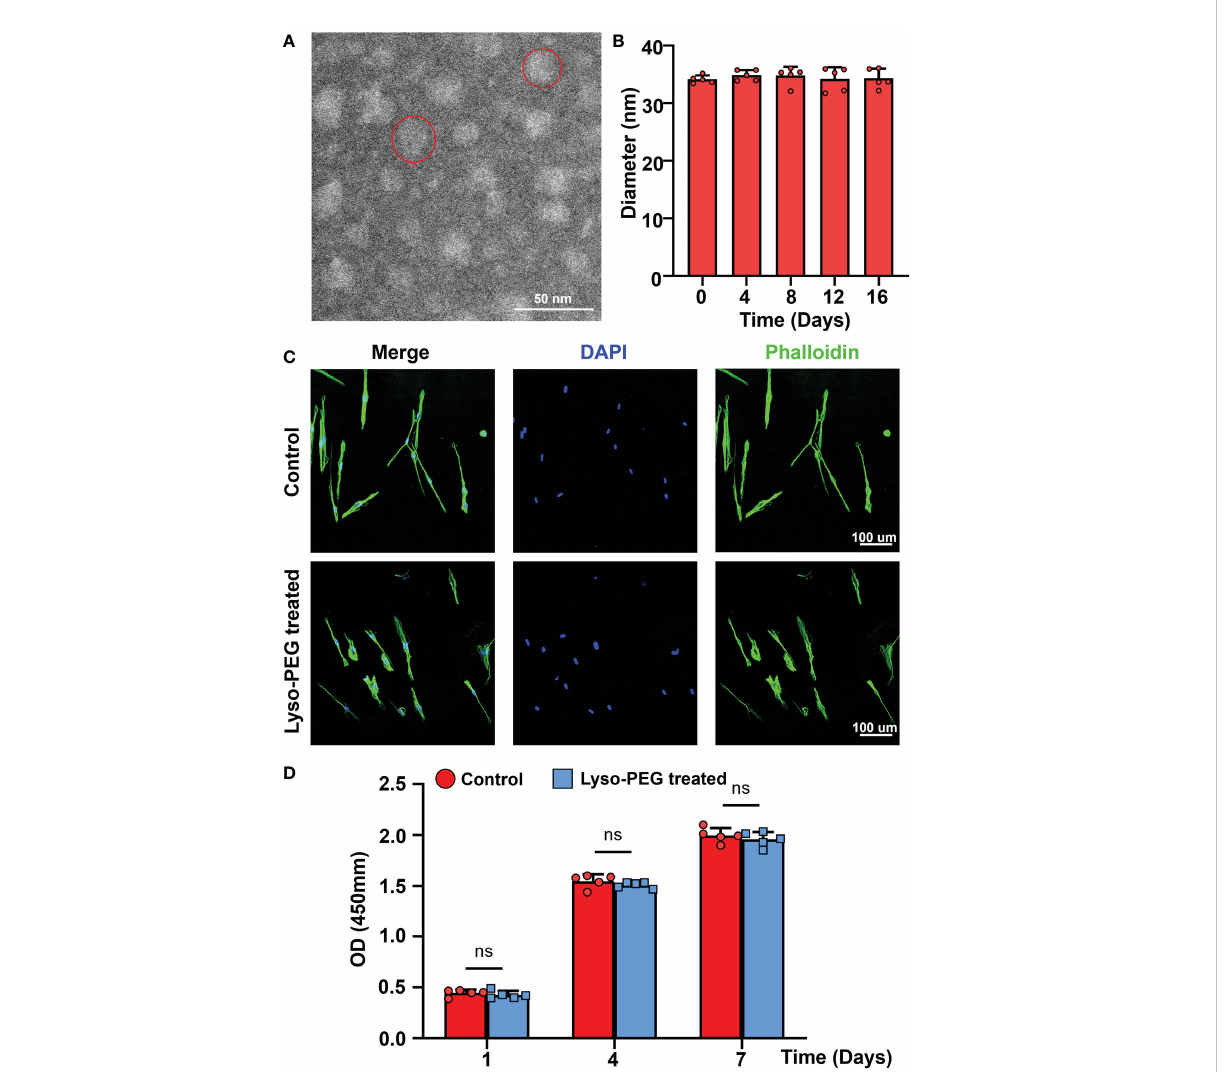
FIGURE 7 Characteristics of Lyso-PEG emulsion. (A) TEM image of the Lyso-PEG oligomeric nanoparticles; the red circle indicates an oligomeric nanoparticle. Scale bar: 50 nm. (B) The diameter of the Lyso-PEG emulsion for 20 d at room temperature (n = 5). (C) CLSM image of SHED on the round coverslip. Scale bar: 100 m m. (D) Cell viability of SHED after 1, 4, and 7 d (n = 5, ns p >